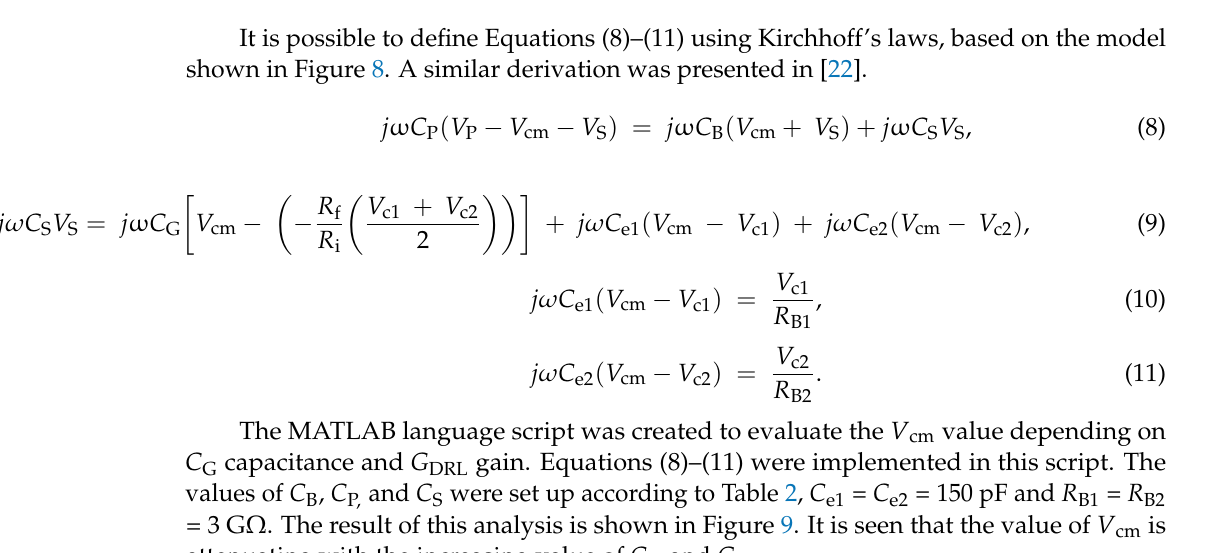
Figure 8. Equivalent schematic of an interference model for the system using a Driven Right Leg (DRL) circuit.